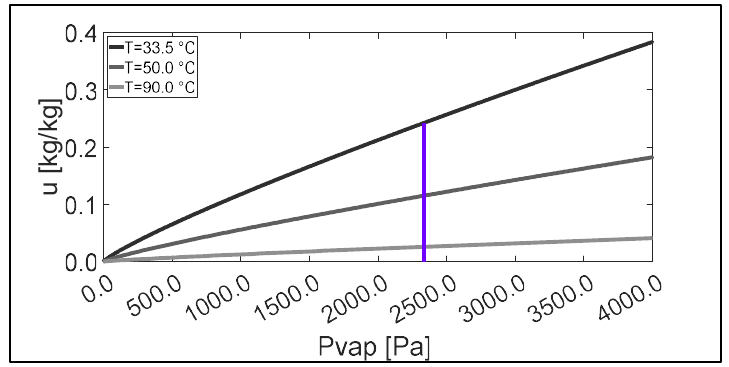
Figure 9. Isotherms of silica-gel under analysis [36].